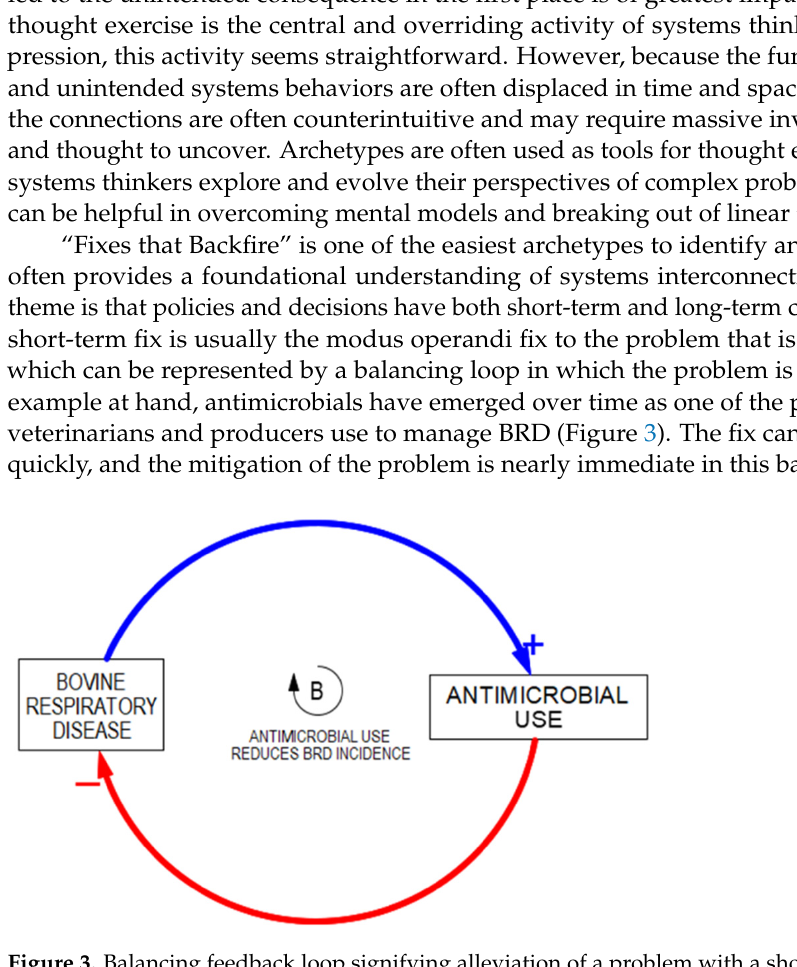
Figure 3. Balancing feedback loop signifying alleviation of a problem with a short-term fix. Arrows connect variables and convey the direction of the relationship with the “+” and “ − “notation.